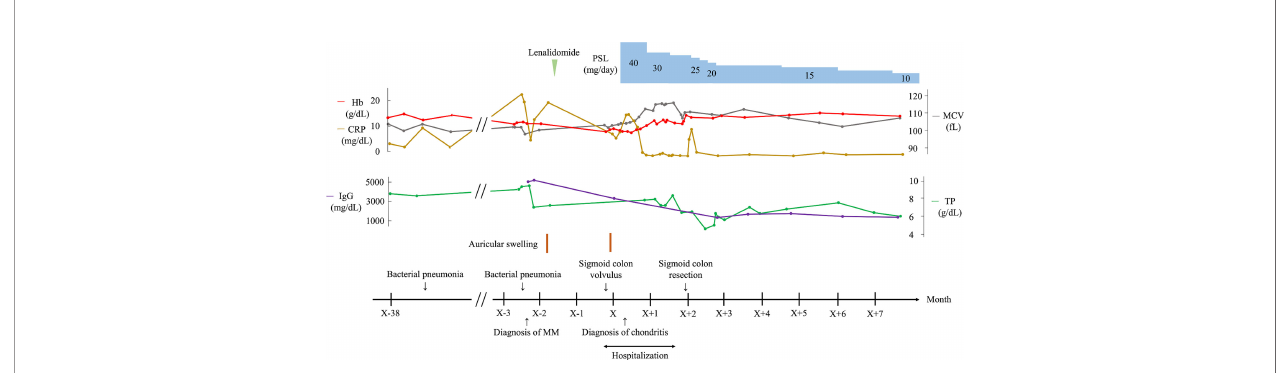
Supplementary Table 1 . Speci fi cally, elevated monoclonal IgG levels at 5,103 mg/dL, anemia (hemoglobin 10.9 g/dL), and hypercalcemia (10.5 mg/dL with albumin correction) were